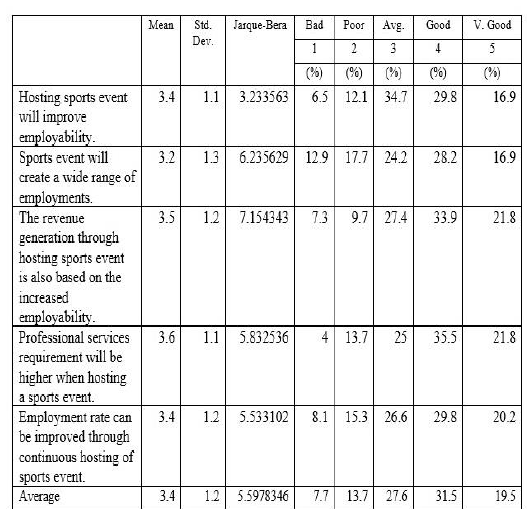
Table 4: Employment